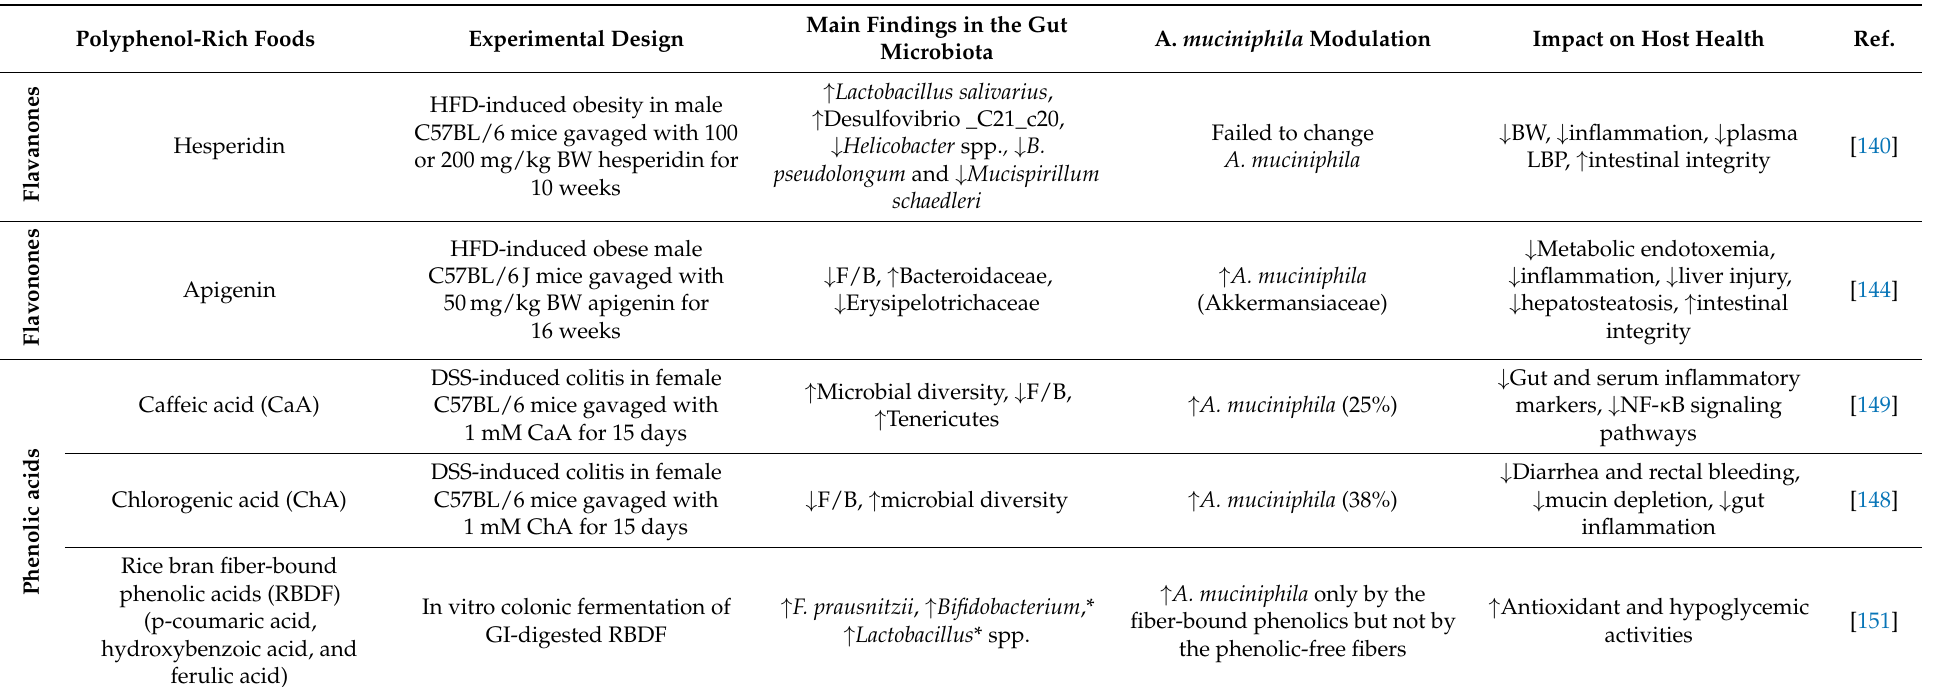
Table 5. Modulation of the gut microbiota and A. muciniphila by flavones and phenolic acids in